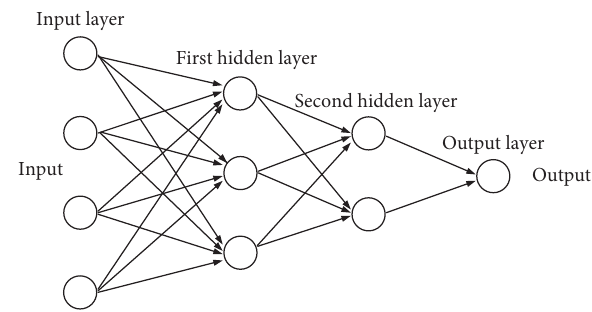
Figure 1: Simple structure of a three-layer MLP model having one input, two hidden, and one output